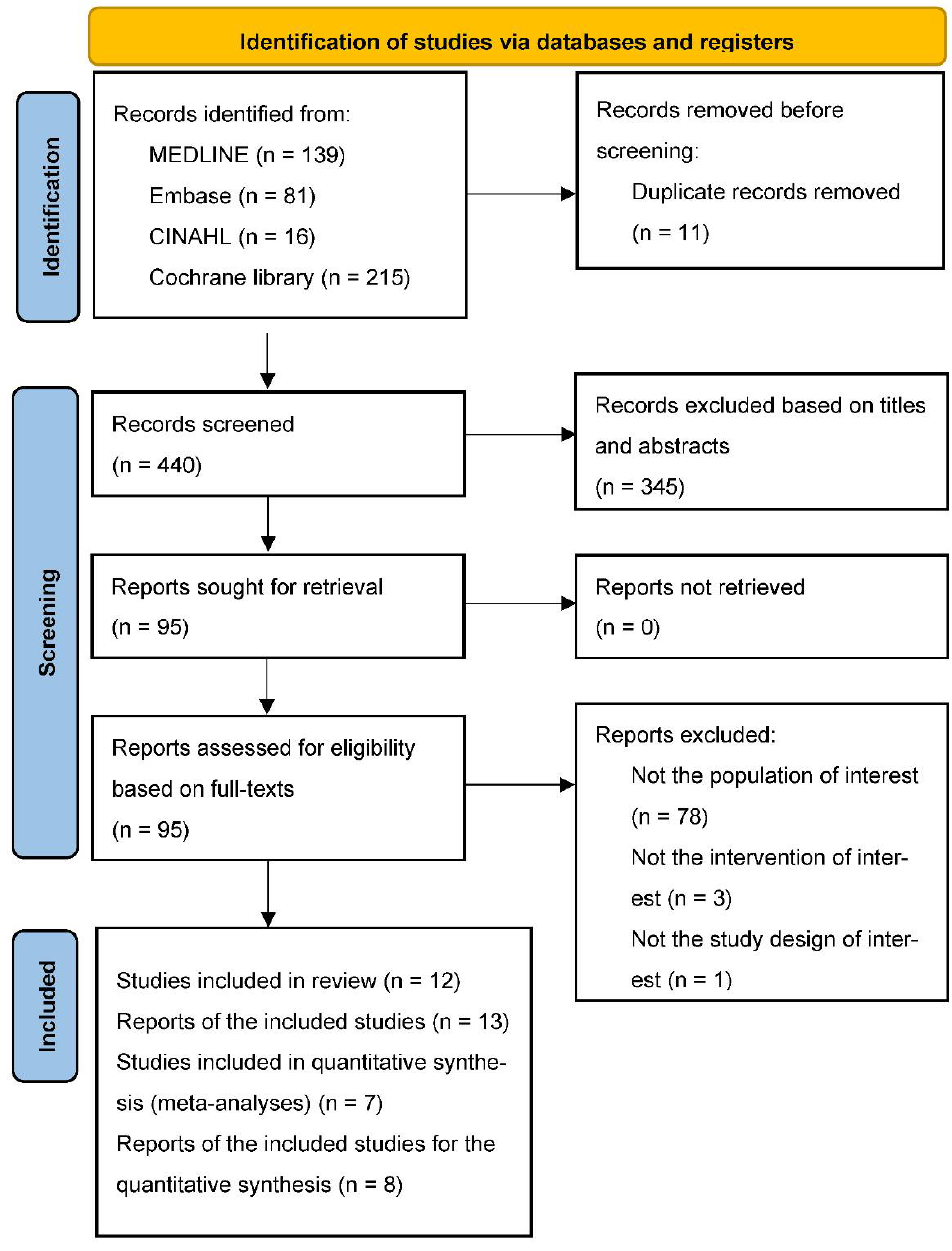
Figure 1. Flow diagram of the study selection process according to the PRISMA Guideline.